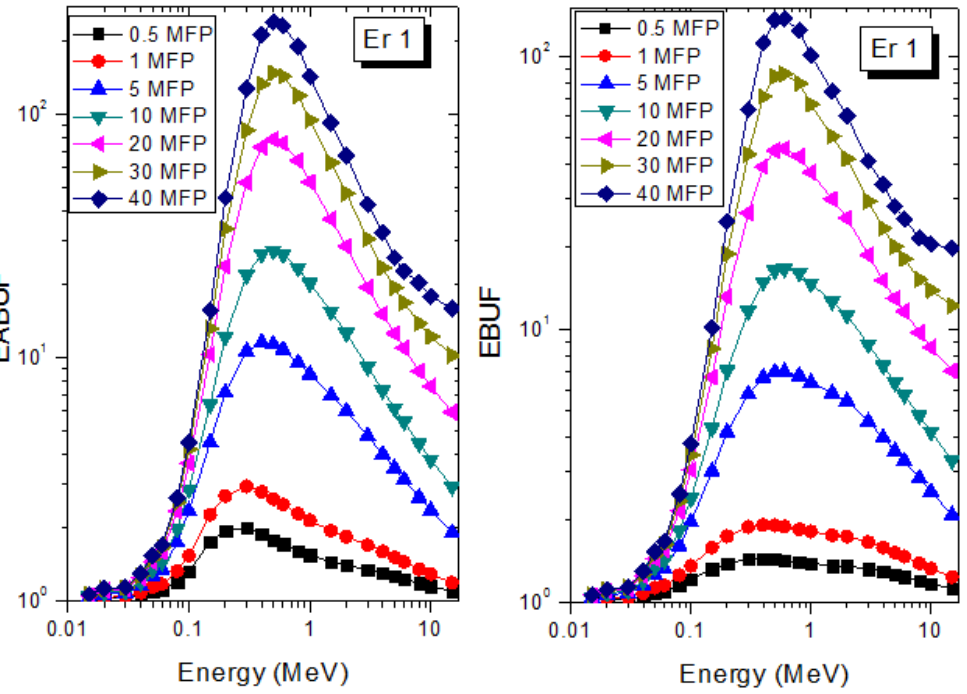
Figure 1. EABUF and EBUF variation with gamma-ray photon energy for Er 1.